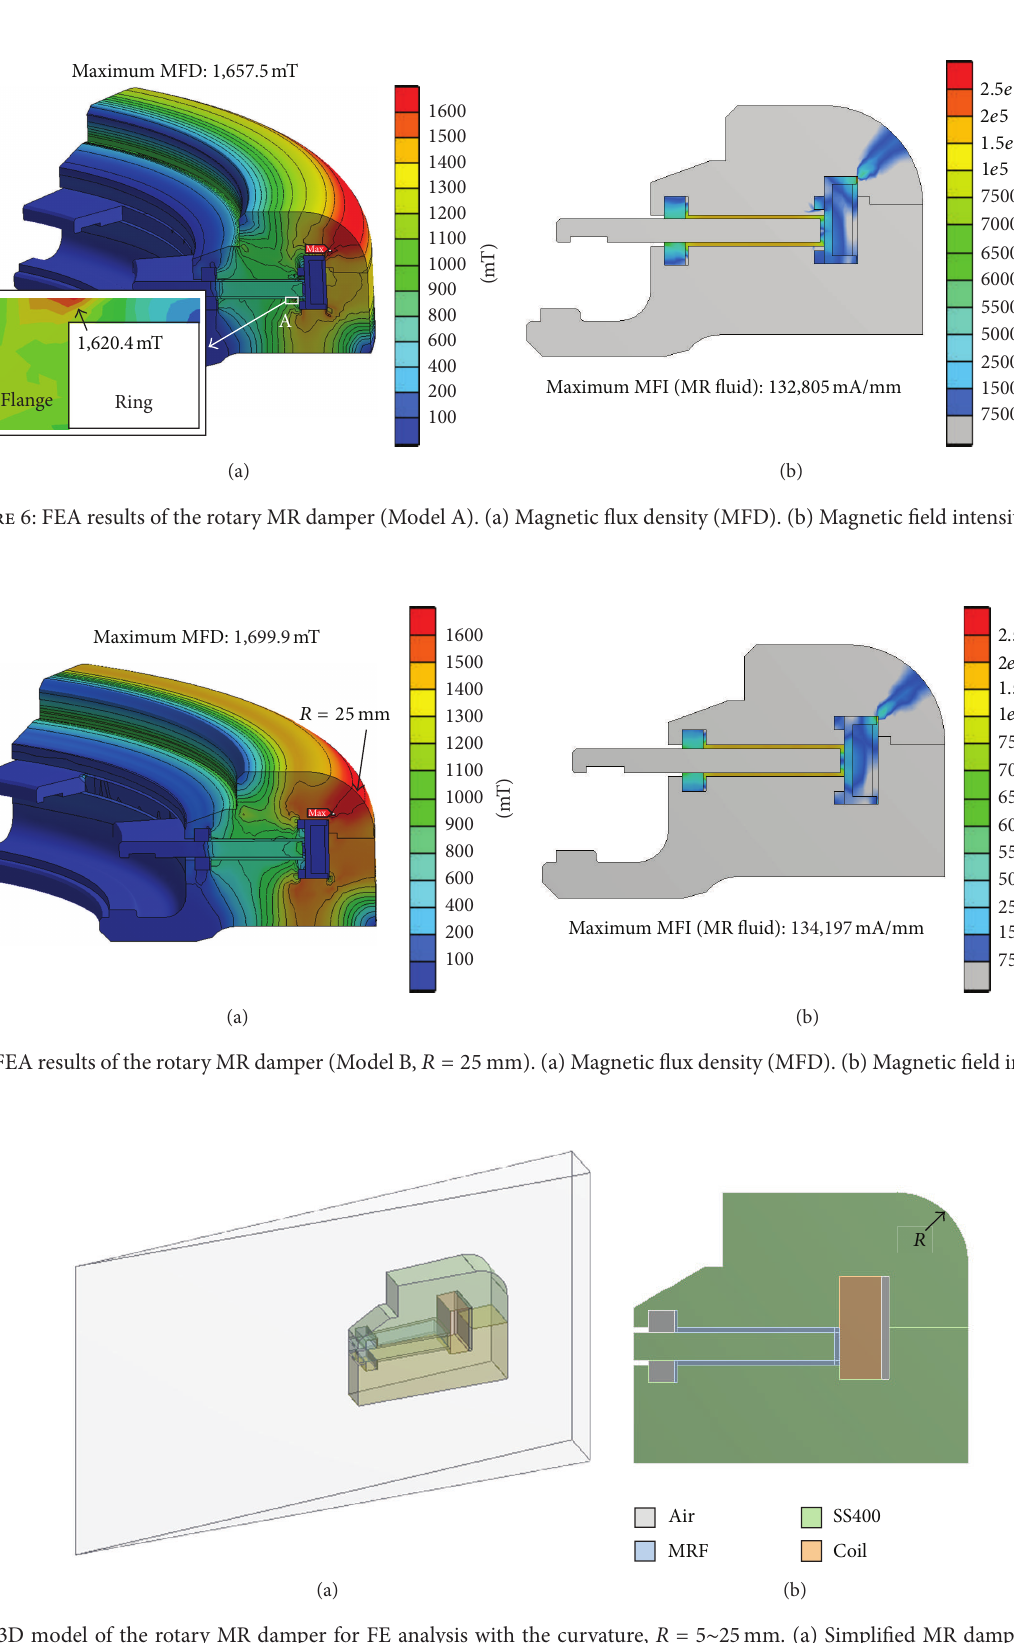
Figure 8: 3D model of the rotary MR damper for FE analysis with the curvature, R = 5 ∼ 25mm. (a) Simplified MR damper model (1/72 symmetric model). (b) Cross-section and component